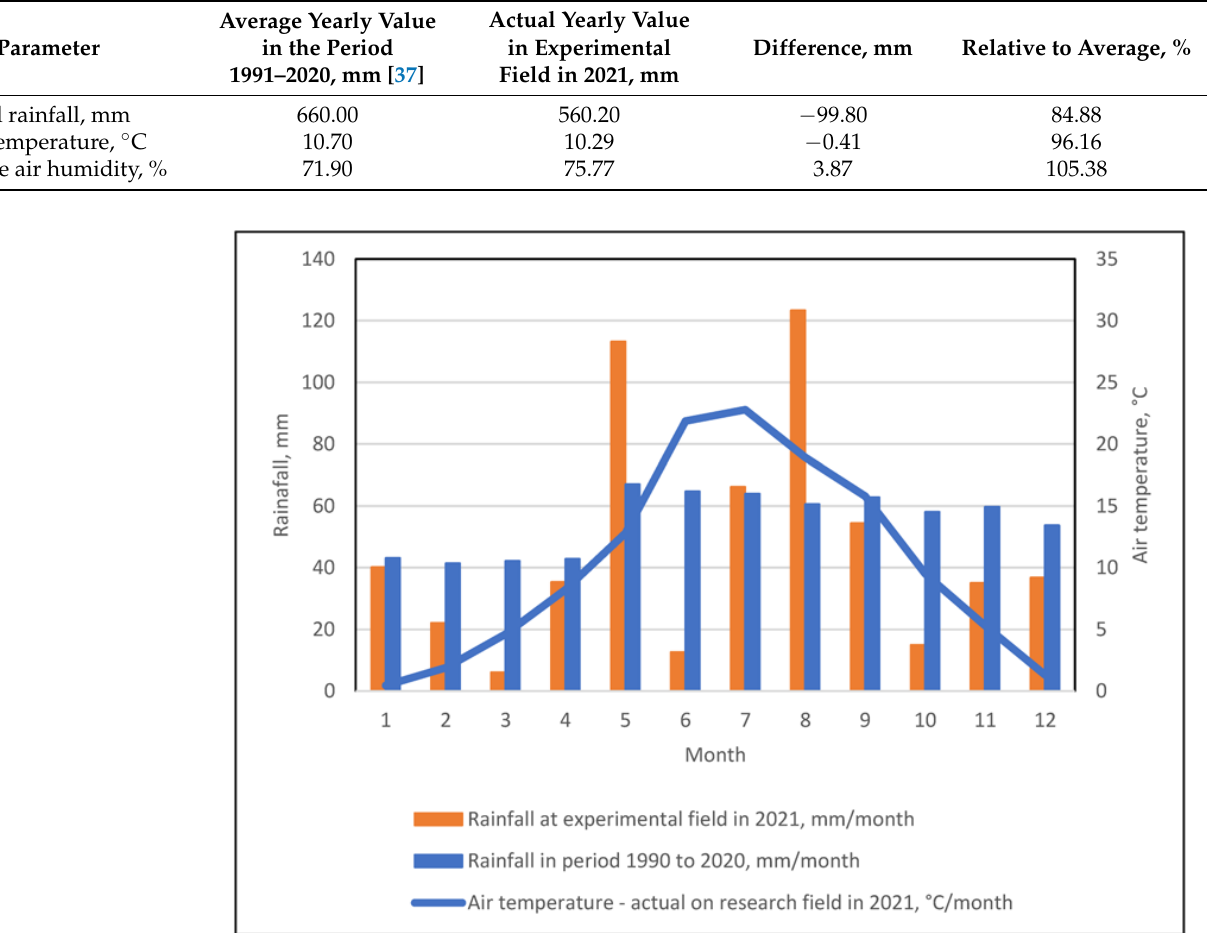
Figure 2. Climate parameters of the experimental field, compared to the long-term average values.